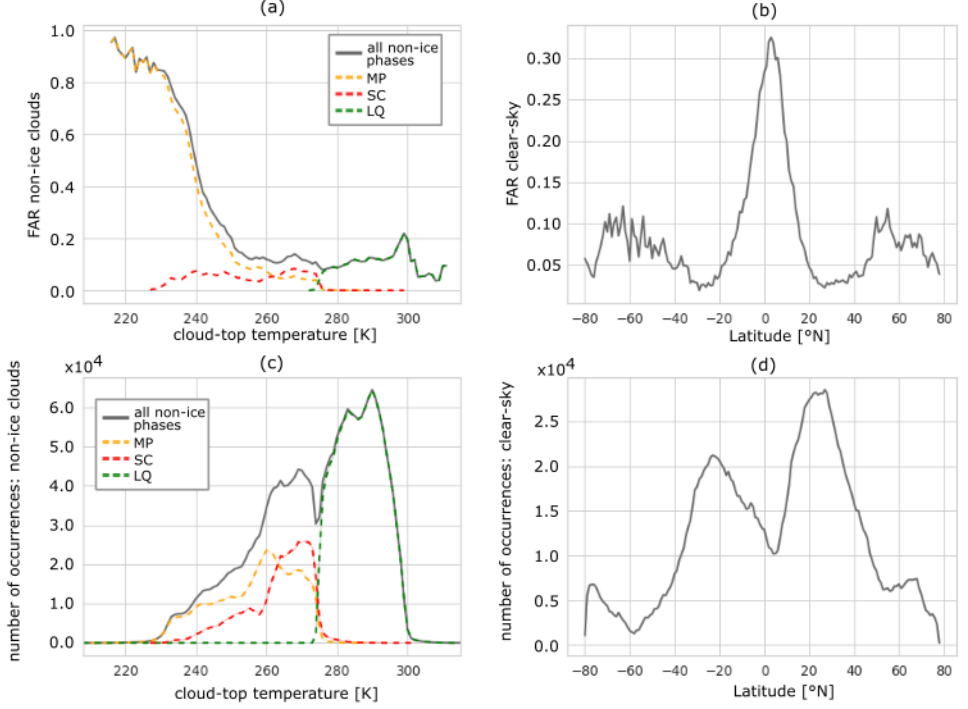
Figure 7. ( a ) FAR of CiPS with respect to non-ice clouds (grey line) as a function of CTT. The dashed lines show the contributions of the different CTPs to the overall FAR; ( b ) FAR of CiPS with respect to clear-sky as a function of latitude; ( c ) Number of occurrences of non-ice clouds in the SEVIRI-like data set (dashed lines show the contributions of the different CTPs); ( d ) Number of occurrences of clear-sky in the SEVIRI-like data